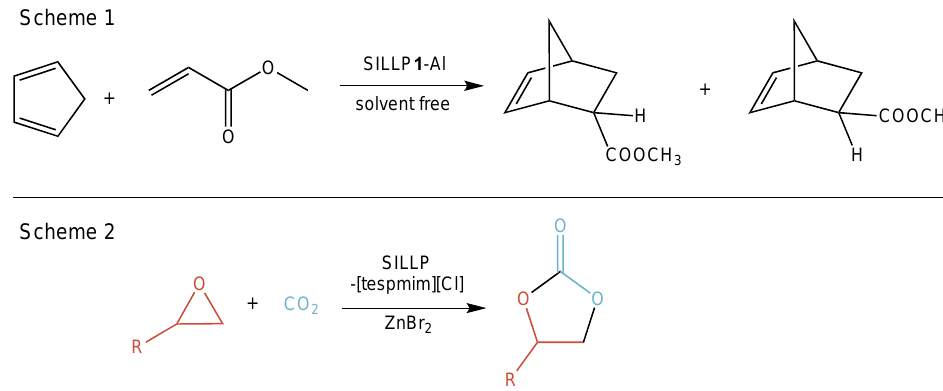
Figure 8. Diels–Alder cycloaddition (Scheme 1) and CO 2 cycloaddition for cyclic carbonates synthesis (Scheme 2) with SILP catalysts.